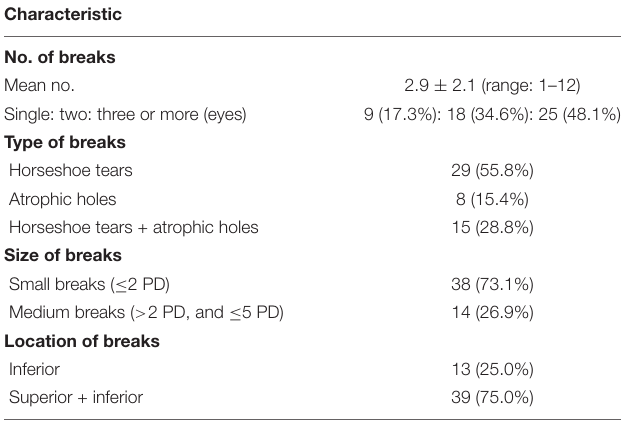
TABLE 2 | Clinical characteristics of retinal breaks.